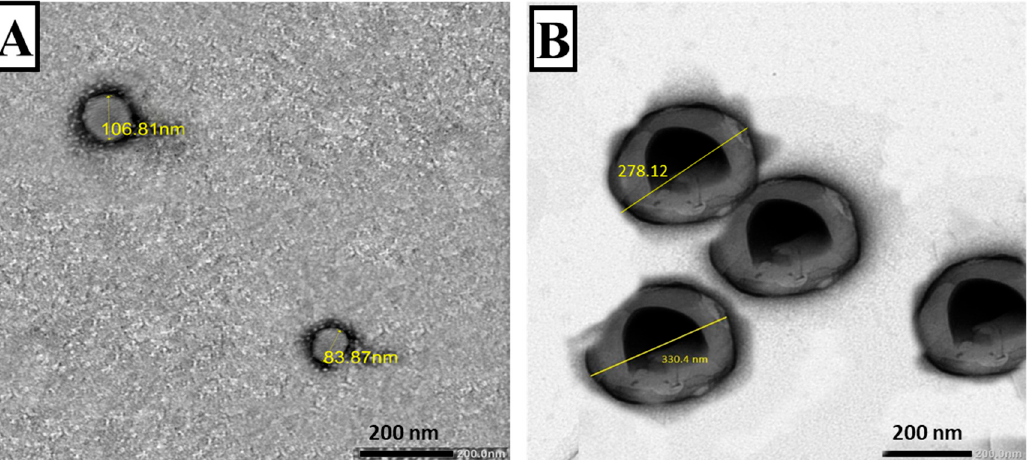
Figure 2. TEM of the prepared nanoparticles (plain and RA-loaded SLNs) (×30,000). ( A ) Plain SLNs displaying round smooth surfaces. ( B ) RA-SLNs showing almost round particles with darker core.